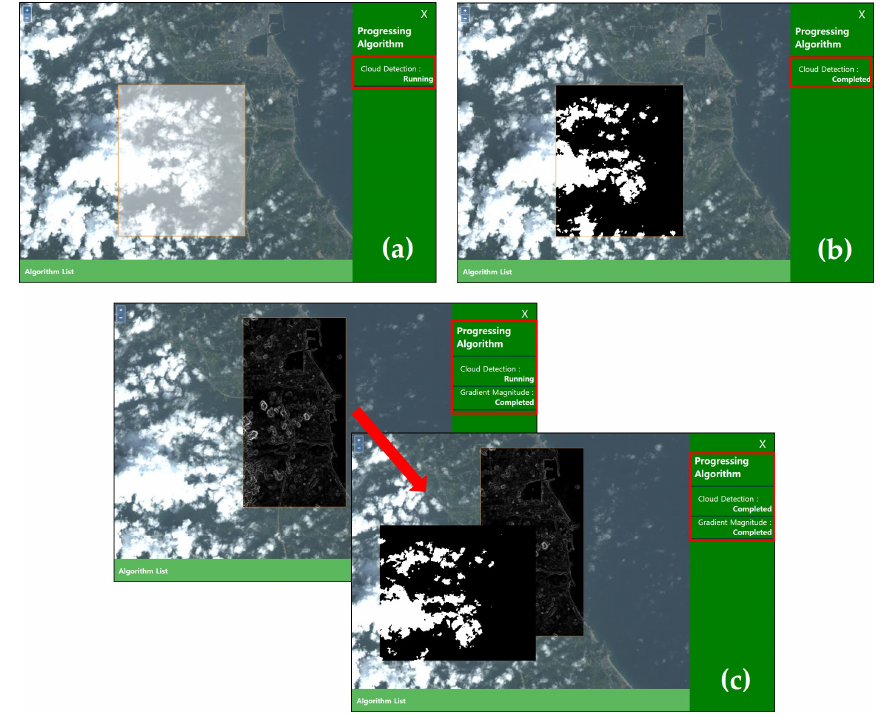
Figure 5. Application of the progressing algorithm: ( a ) running process—GetStatus request; ( b ) Figure completed process and result—GetResult request; ( c ) multiprocessing and results.